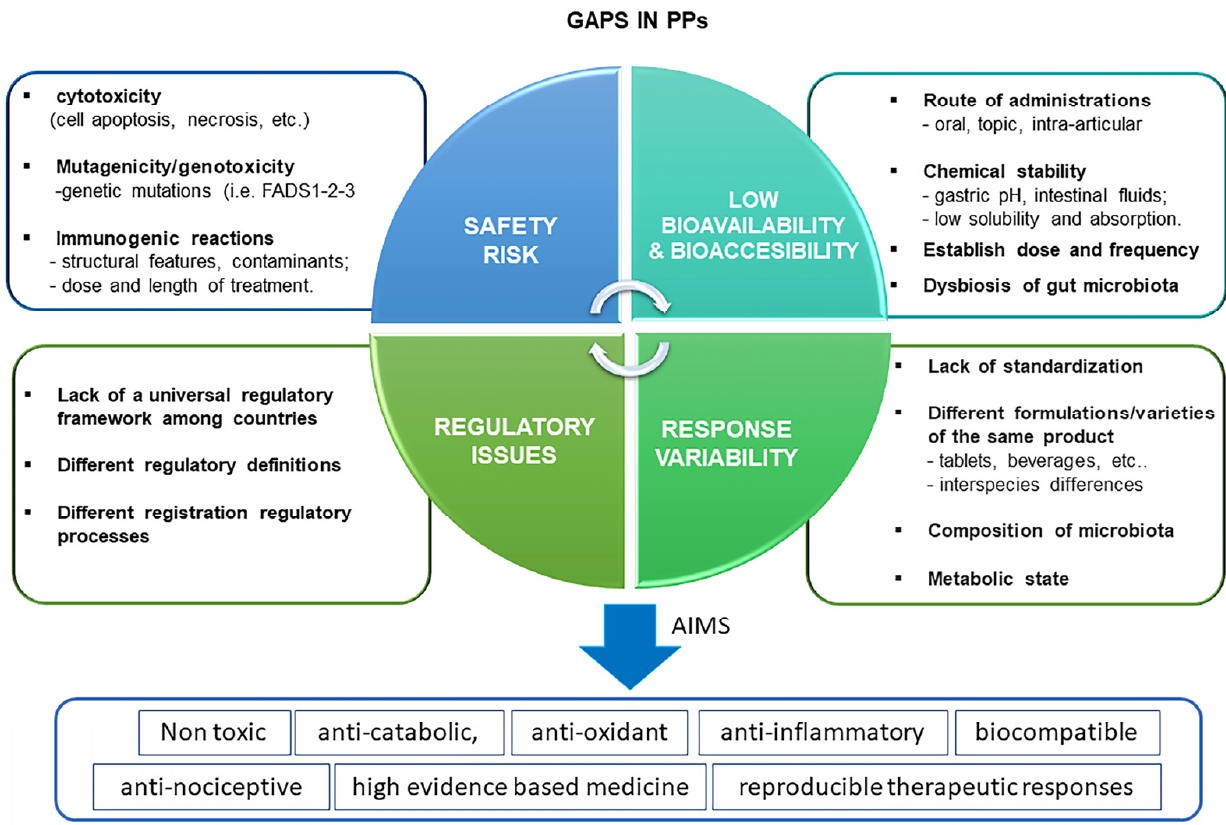
Figure 3. Schematic representation of main knowledge gaps for the use of PPs for the treatment of OA. The main limitations of their use include mainly the consideration of four aspects: safety, bioavailability, response variability and regulatory aspects. A safety profile should be devoid of cytotoxicity (absence of cell apoptosis, death, etc.), mutagenicity and genotoxicity and immunogenic reactions at a local and systemic level. Bioavailability depends on a certain number of factors, including the route of administration, chemical stability, dose and frequency of BDMs, and gut microbiota (dysbiosis). Response variability of BDMs is closely dependent on the lack of standardization, different formulations batch variations, metabolic state, and microbiota composition which render unreproducible therapeutic effects among OA patients. Finally, the regulatory aspect is another critical limitation due to the lack of universal rules which govern the BDMs process worldwide.